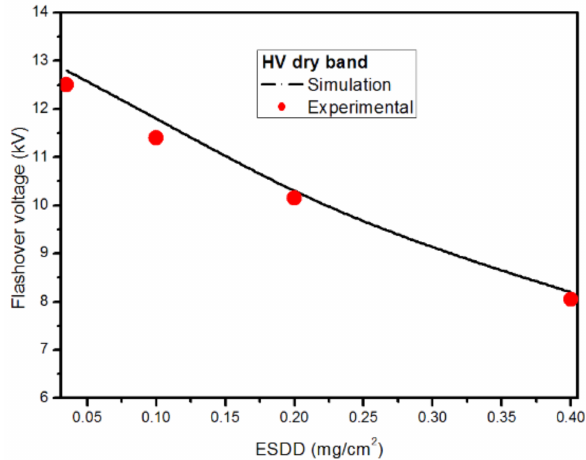
Figure 18. Flashover voltage for a high voltage end dry band at different ESDD levels.